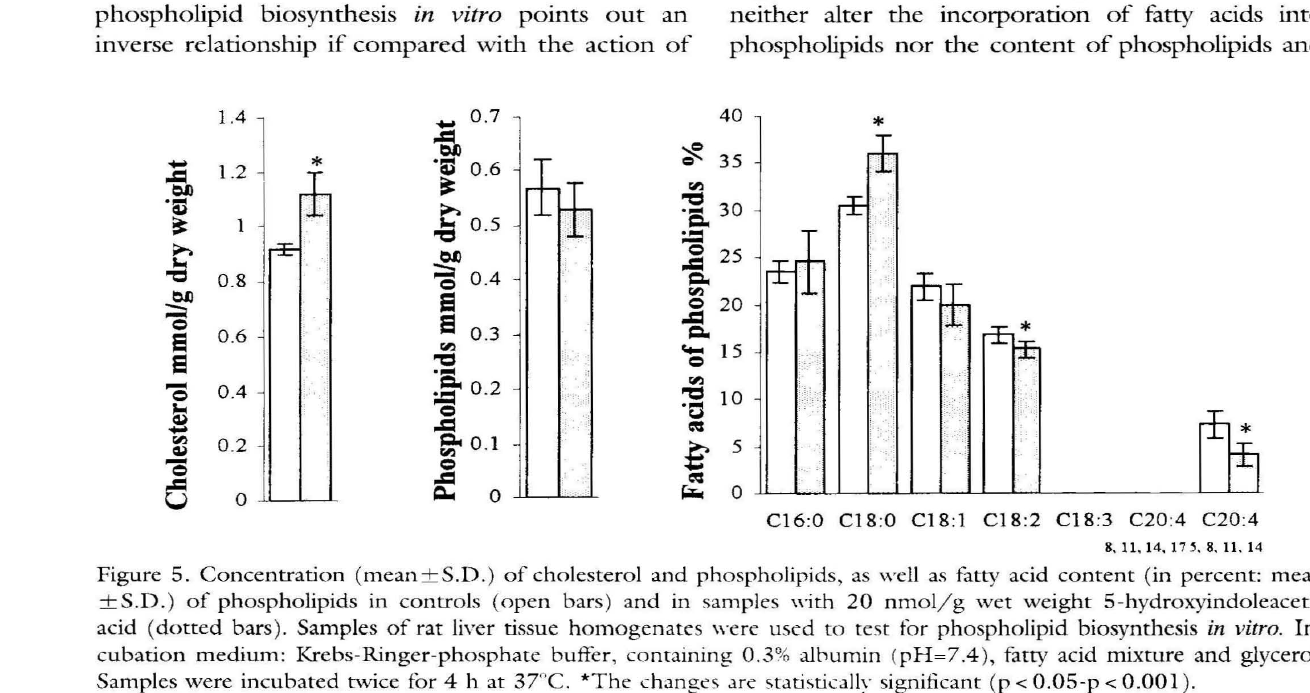
increased in samples contammg serotonin, while the amount of phospholipids remained unchanged. Figure 4 shows the influence of serotonin together with iproniasid and of iproniasid alone on phospholipid biosynthesis m vitro. The addition of serotonin together with inhibitor of monoamine oxidase to incubation medium for phospholipid biosynthesis in vitro points out an inverse relationship if compared with the action of